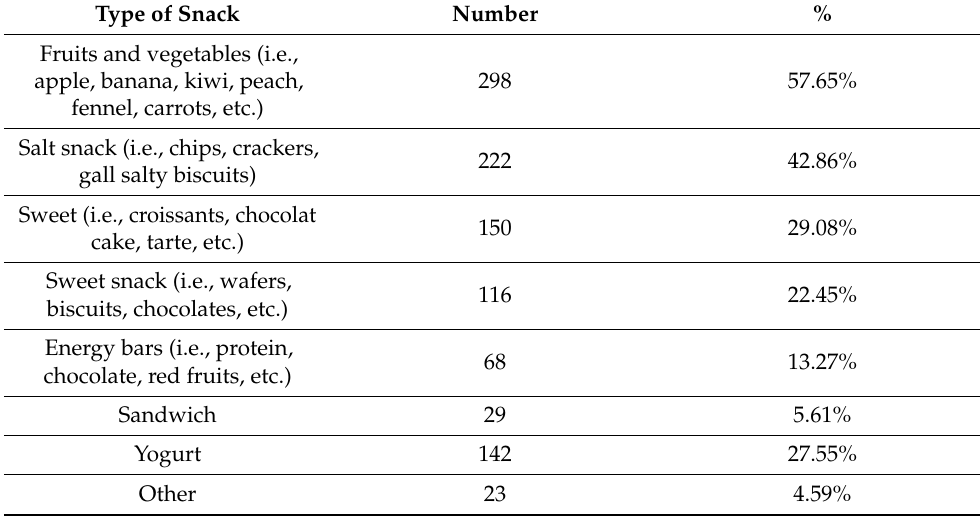
Table A5. Type of snacks consumed among the sample (in % of respondents).